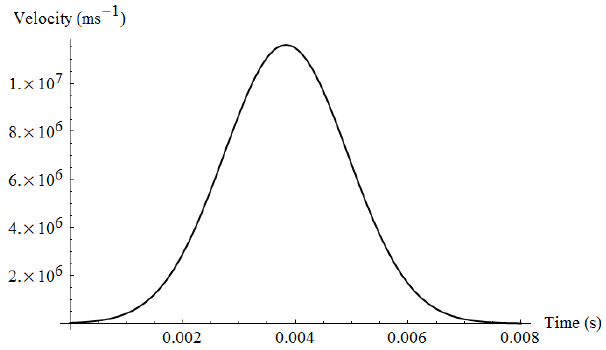
Figure 9: Velocity of red sprites with time.